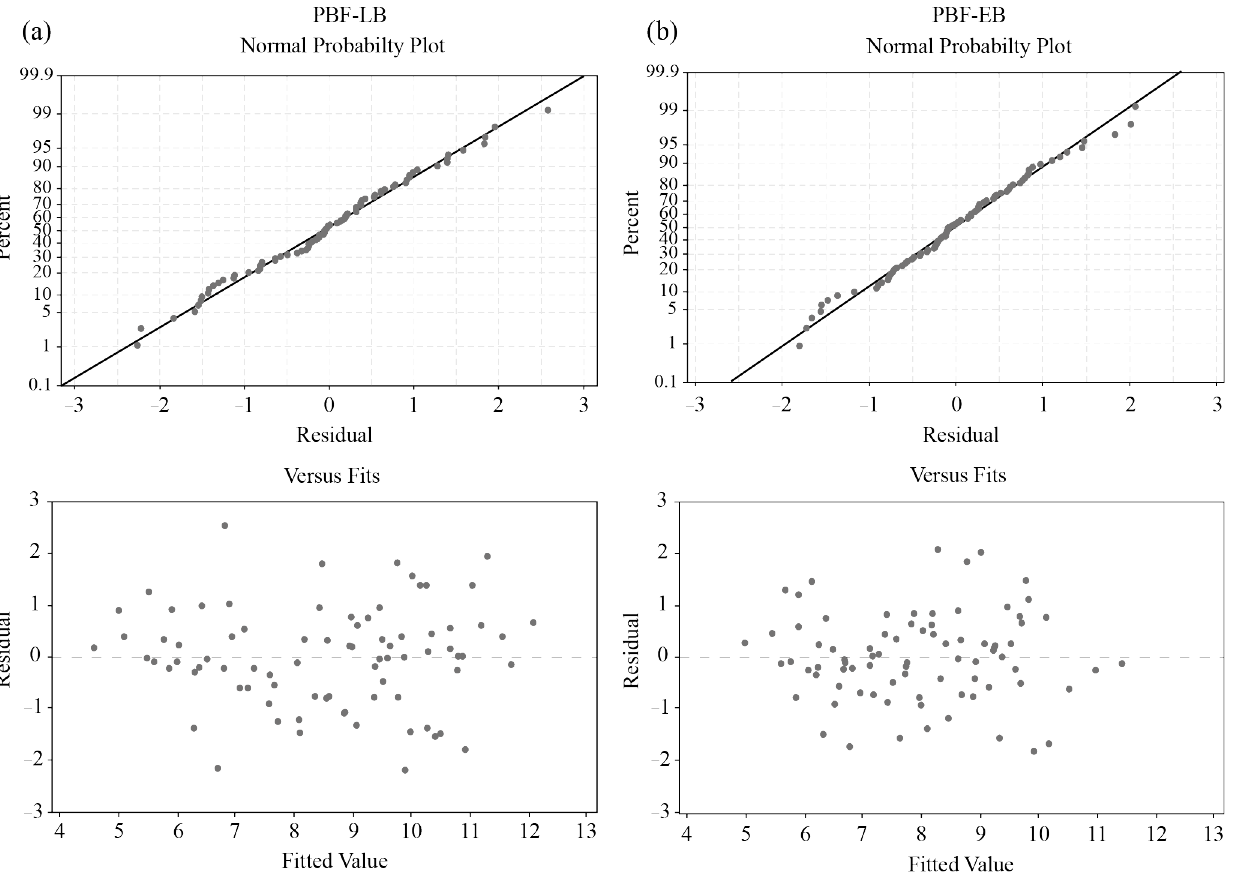
Figure A2. Residuals plots of the Ra x regressions models for ( a ) PBF-LB and ( b ) PBF-EB.